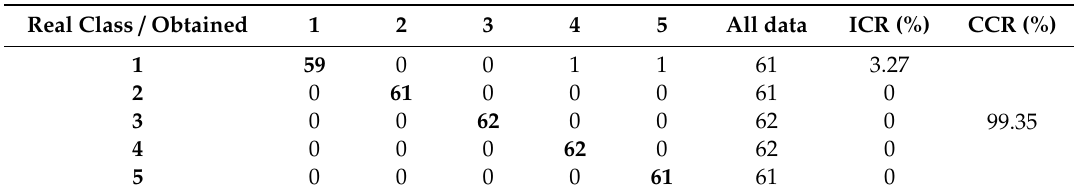
Table 5. Classification results of the test set using the featureless classification approach. ICR: incorrect classification rate by class; CCR: global correct classification rate.